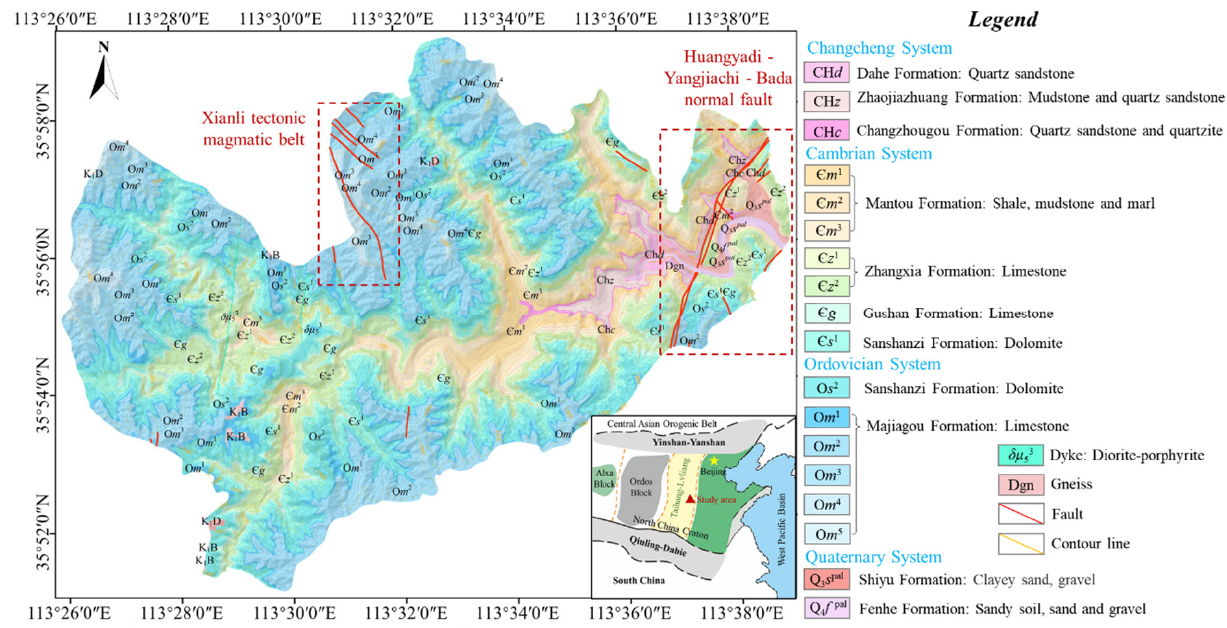
Figure 2. Geological map of the study